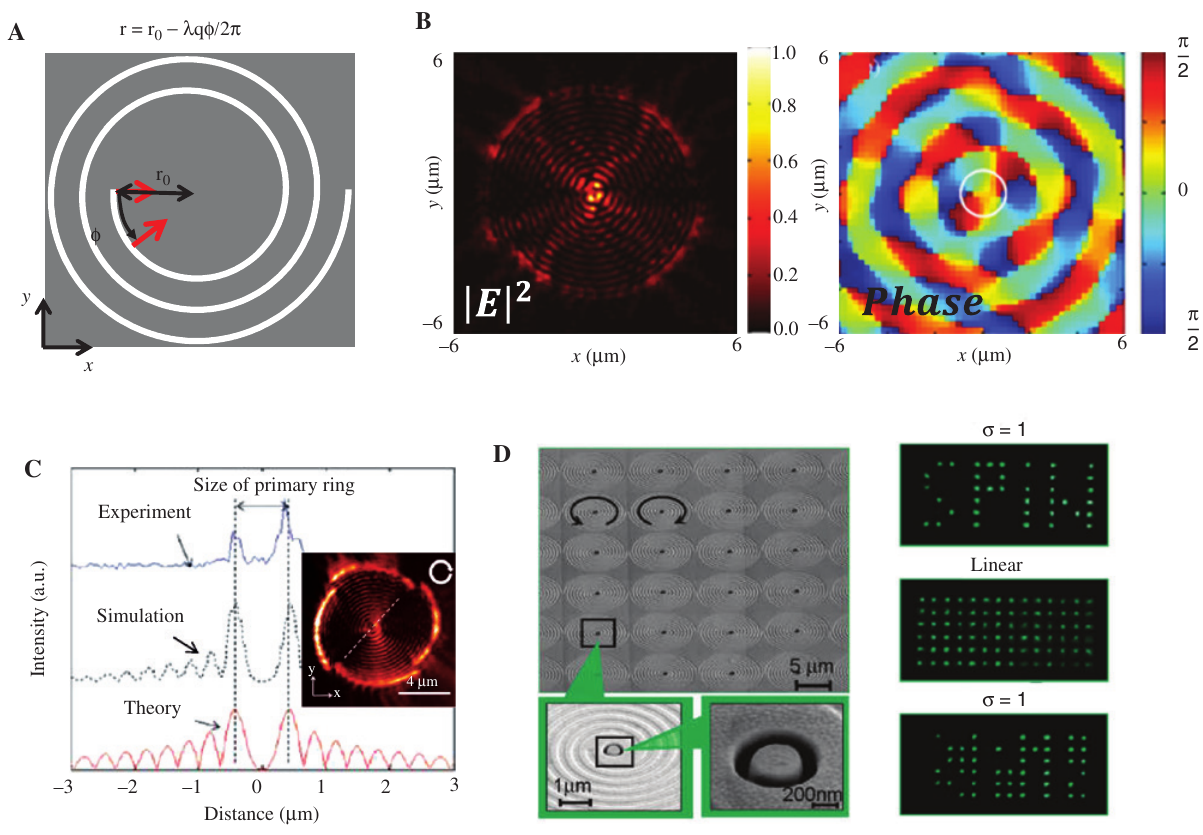
Figure 7: Spiral structures for OAM control in near field. (A) Schematic diagram of the Archimedes spiral in generating surface plasmon. (B) Electric field of the generated surface plasmon on a metal surface. Reprinted from Ref. [88]. (C) Near-field measurement of the OAM of the generated surface plasmon. Reprinted from Ref. [89]. (D) Spin filter with each pixel consisting a spiral with a coaxial nanoaperture. Measured spin-dependent transmission through the array is shown on the right. Reprinted from Ref.